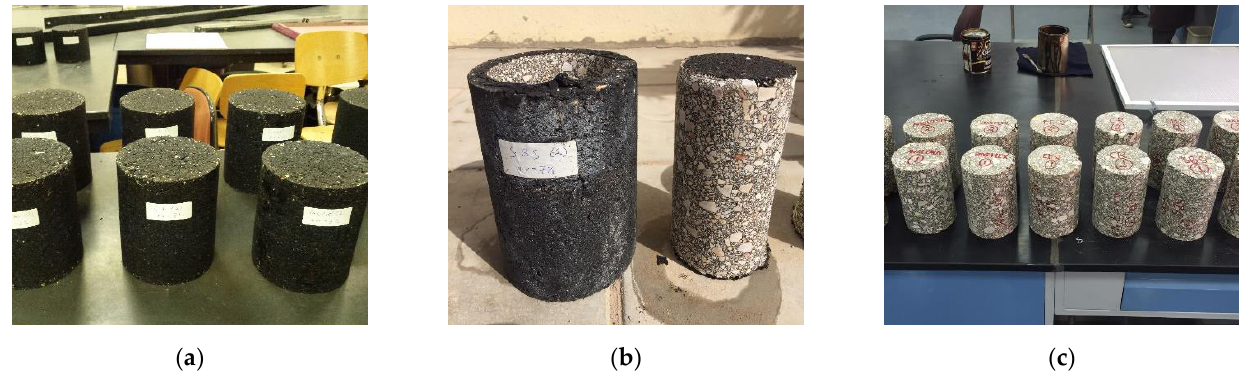
Figure 4. Preparation of test specimens ( a ) compacted specimens, ( b ) Cored specimens, ( c ) ends cut specimens.